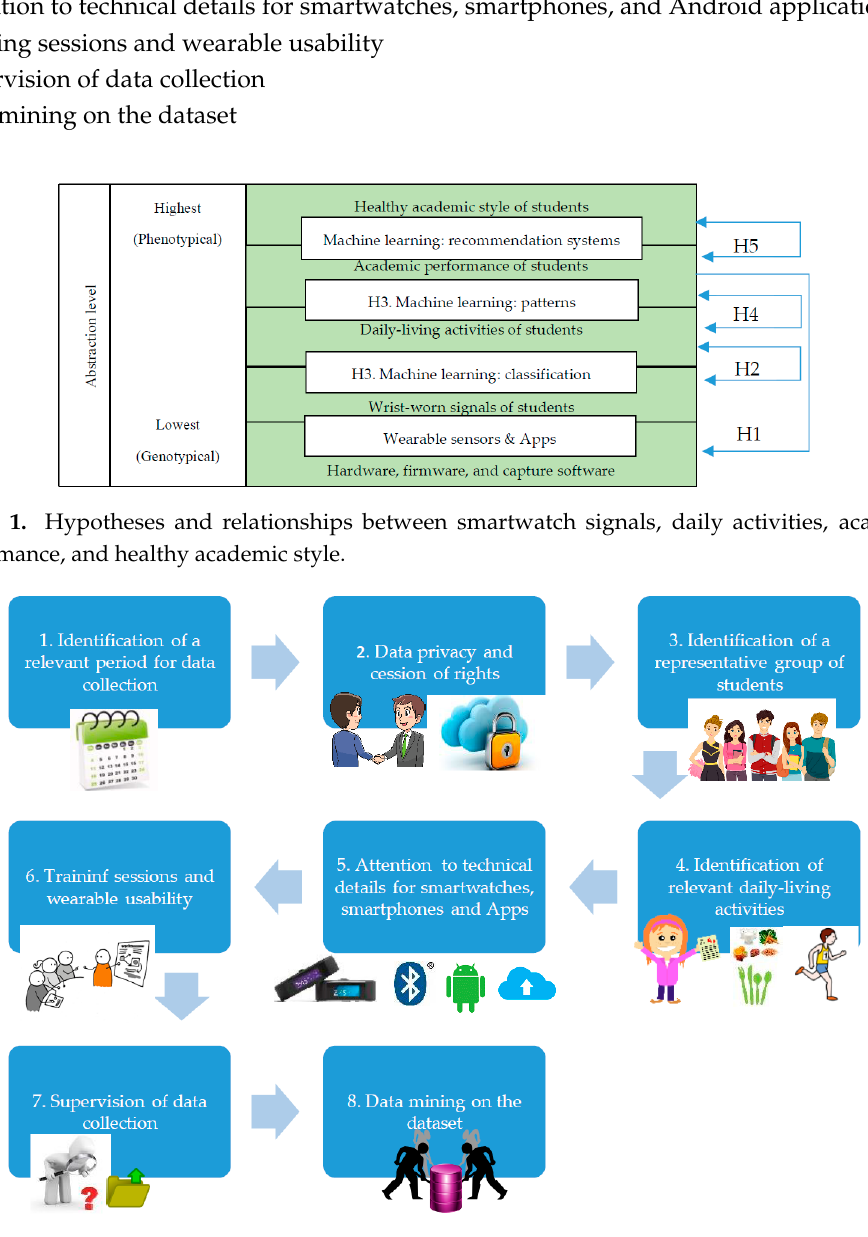
Figure 2. Concept proof methodology for activity monitoring of students with Microsoft Bands, smartphones, and Android Applications.